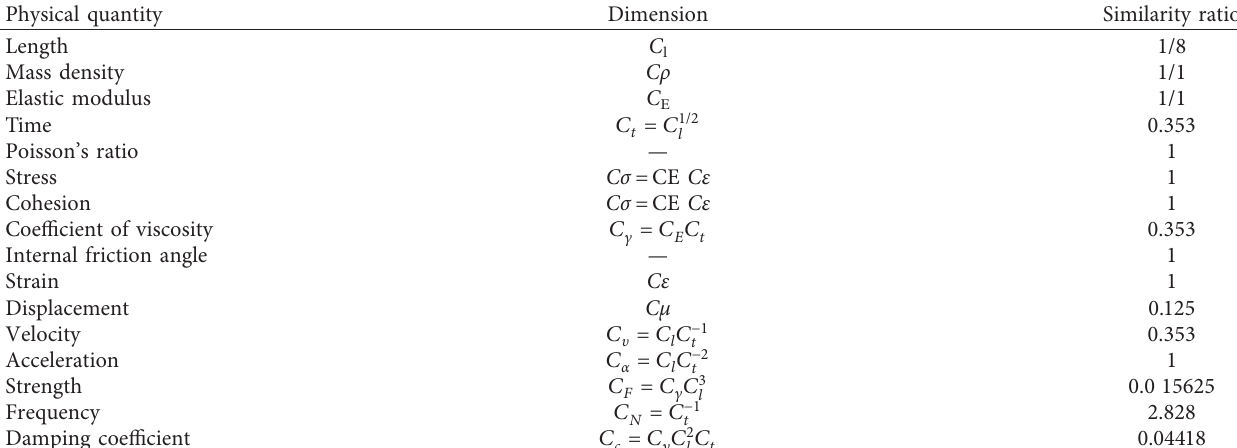
Table 2: Physical dimension and similarity relation of model test.